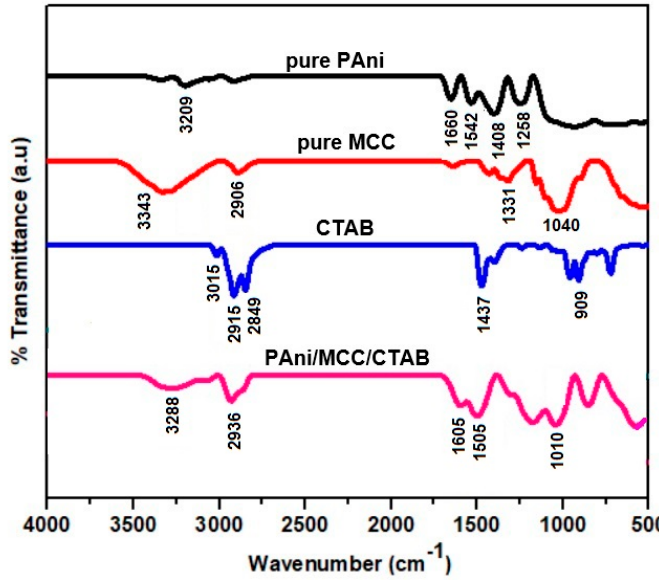
Figure 3. FT-IR spectra of pure PAni, pure MCC, CTAB, and PAni/MCC/CTAB nanocomposite.